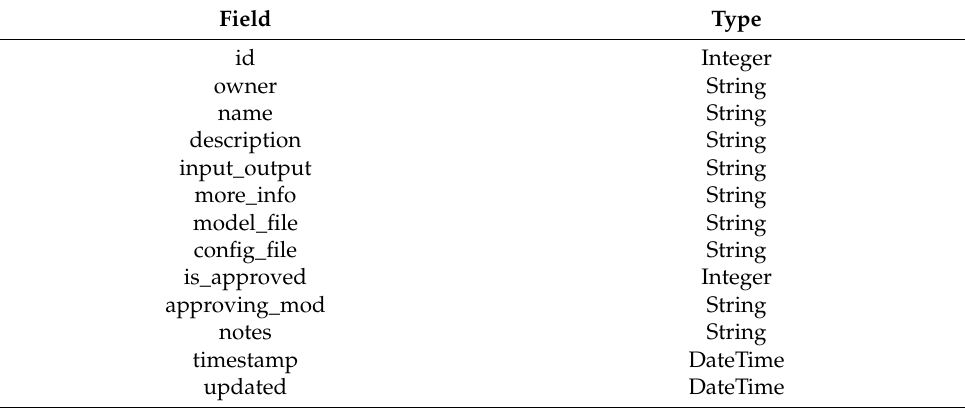
Table A7. Fields and their types for the Model table in the